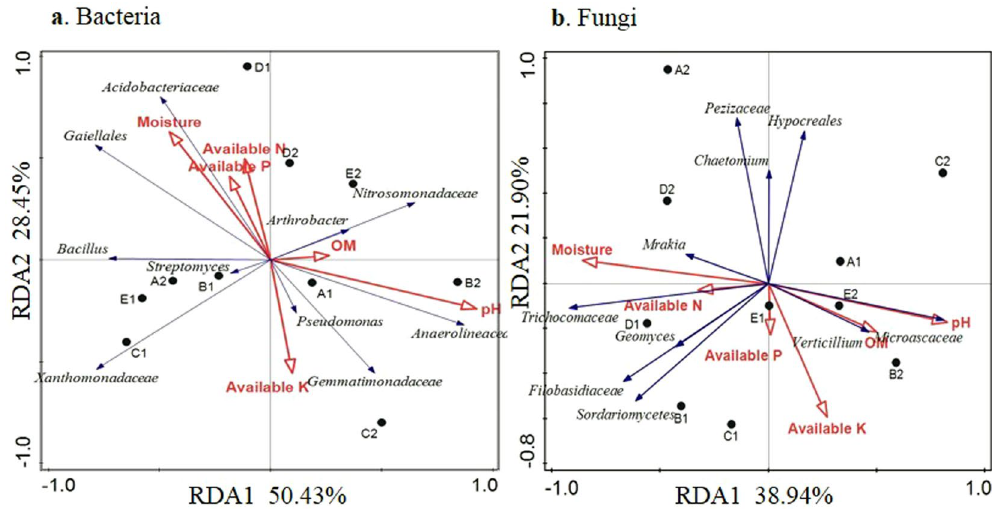
Figure 3. Redundancy analysis of abundant bacterial ( a ) and fungal ( b ) genus and soil properties for PAT and ATS samples from 5 sampling areas. The “A1”, “B1”, “C1”, “D1” and “E1” refers to the five PAT soils in